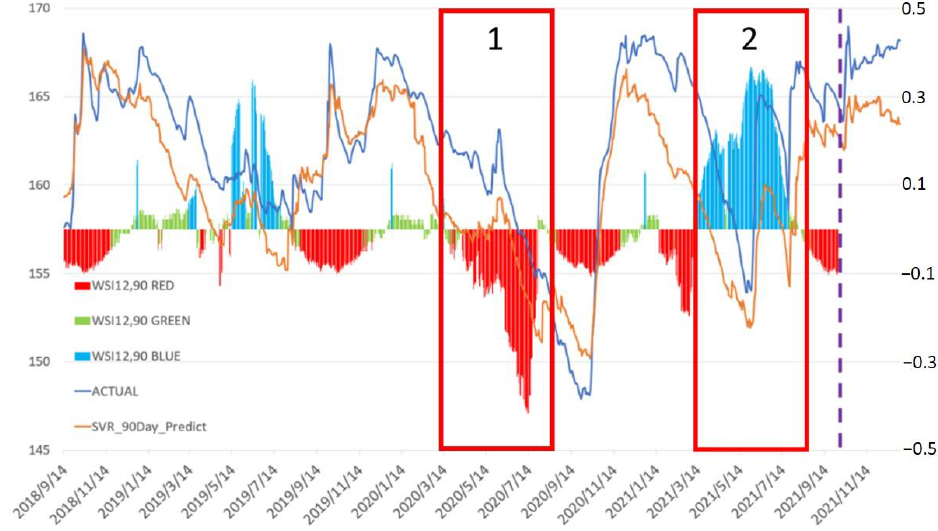
Figure 11. Analysis result of WSI 12,90 .